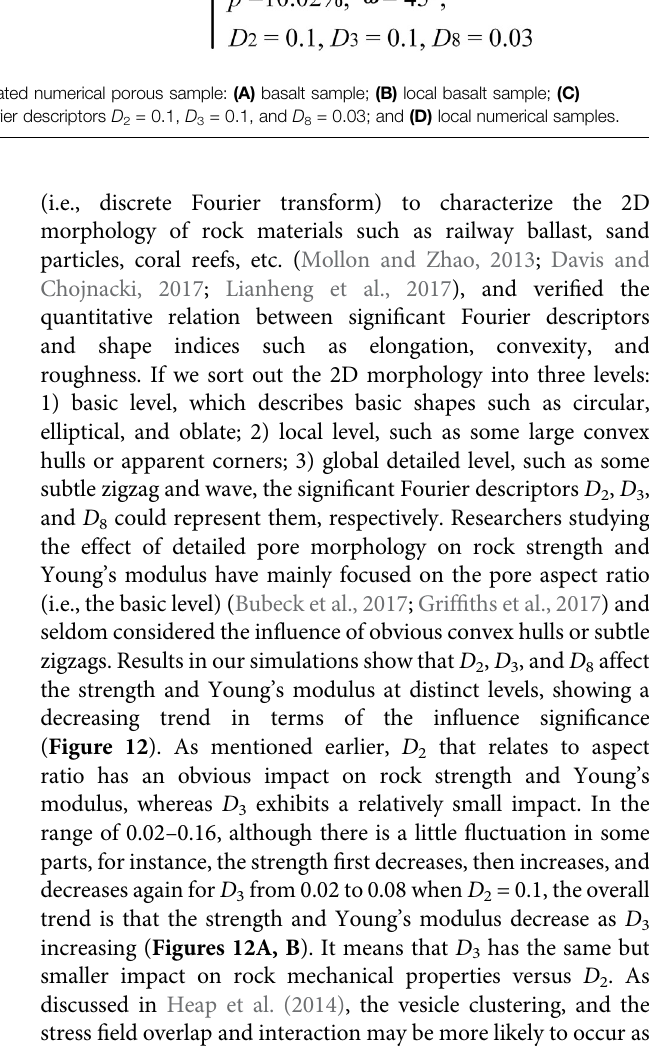
Frontiers in Materials |